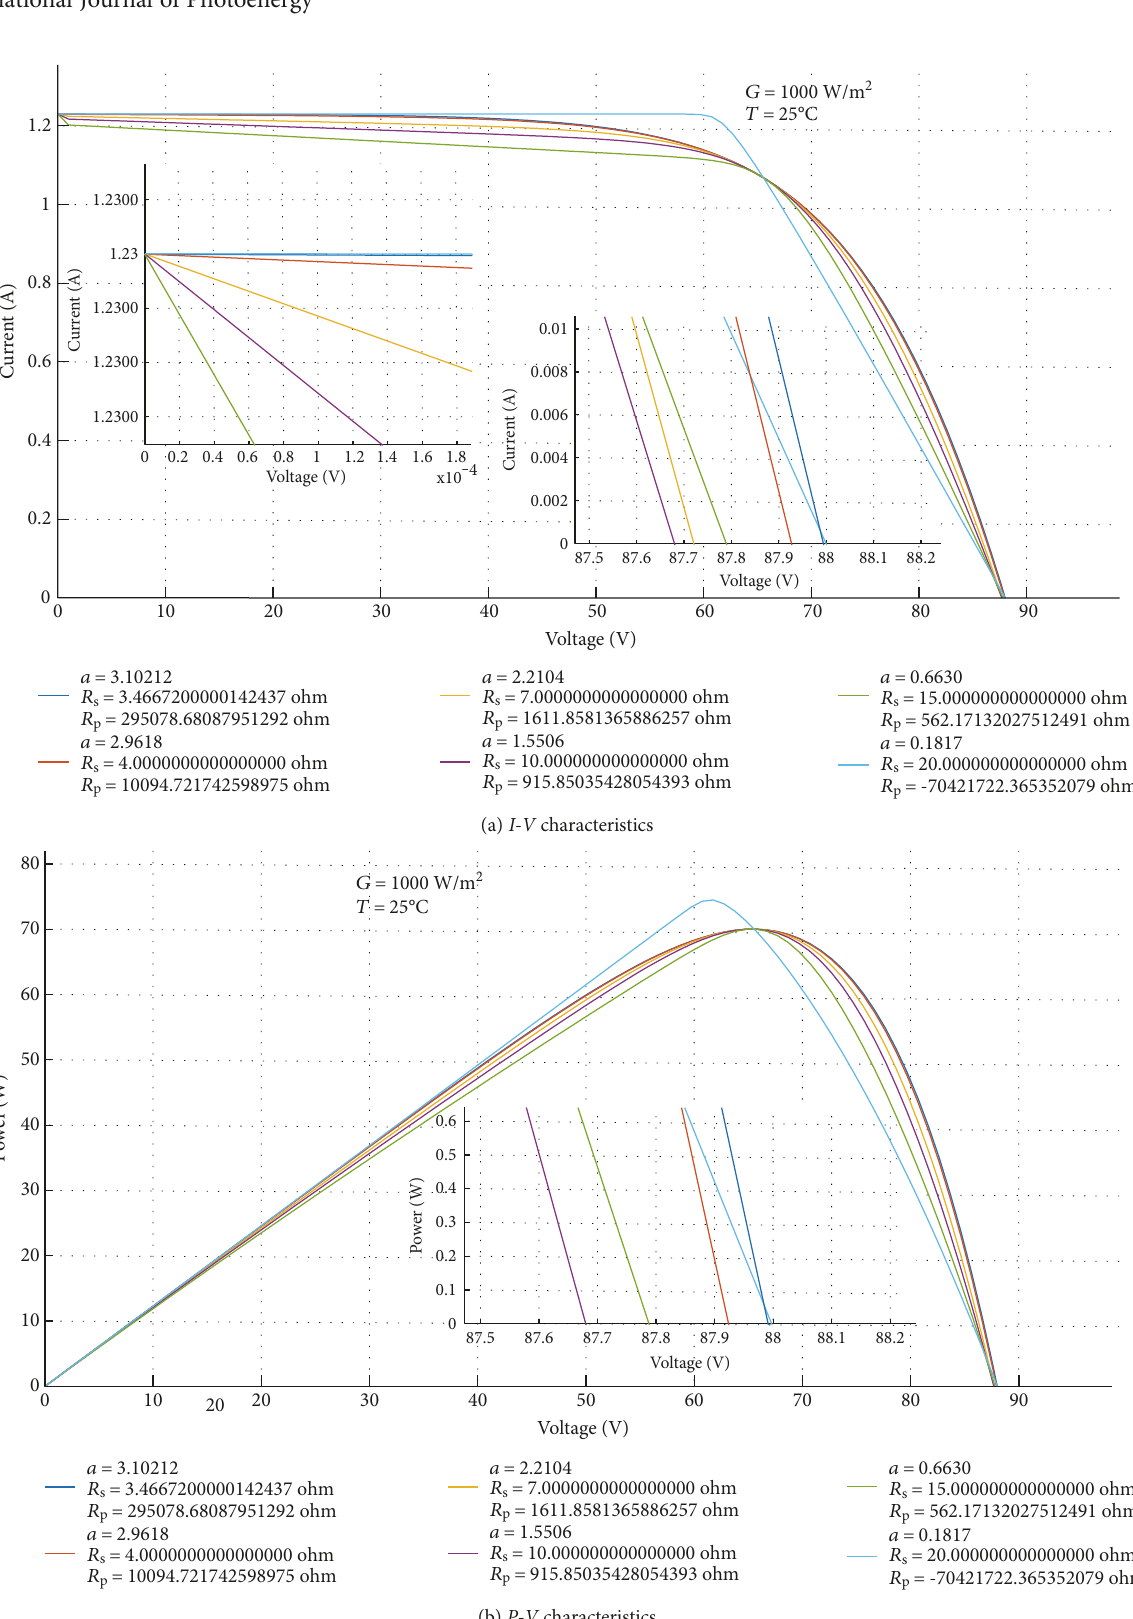
and the corresponding values of a s STC